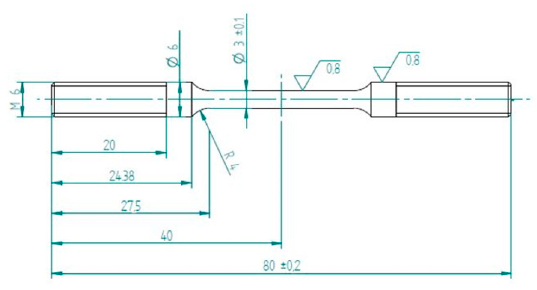
Figure 1. Tensile test sample. All measurements in mm, roughness in µm.